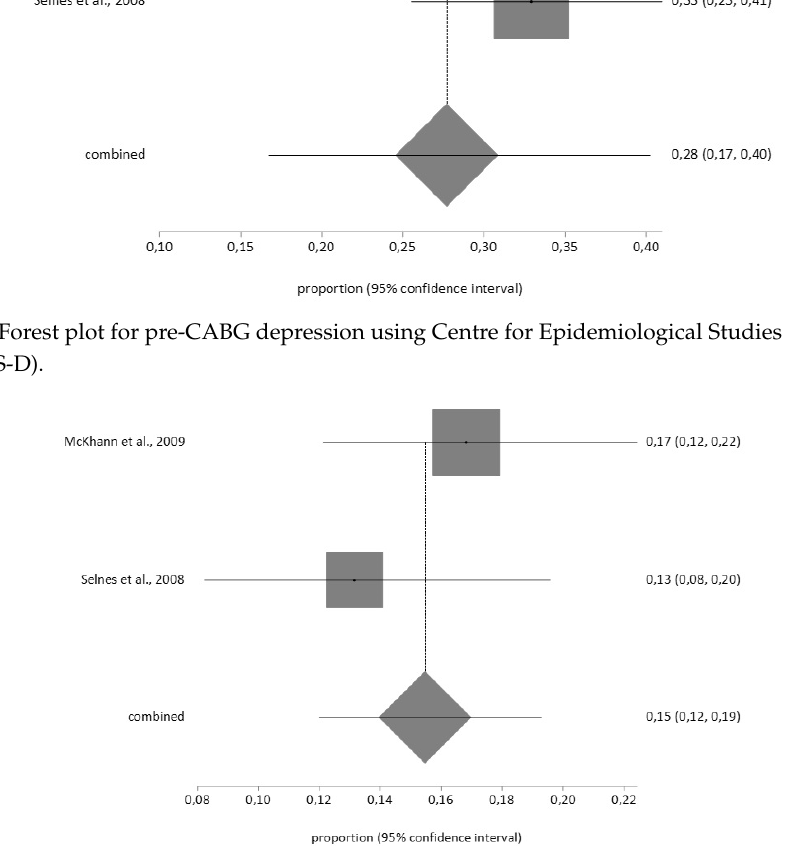
Figure 9. Forest plot for post-CABG depression using